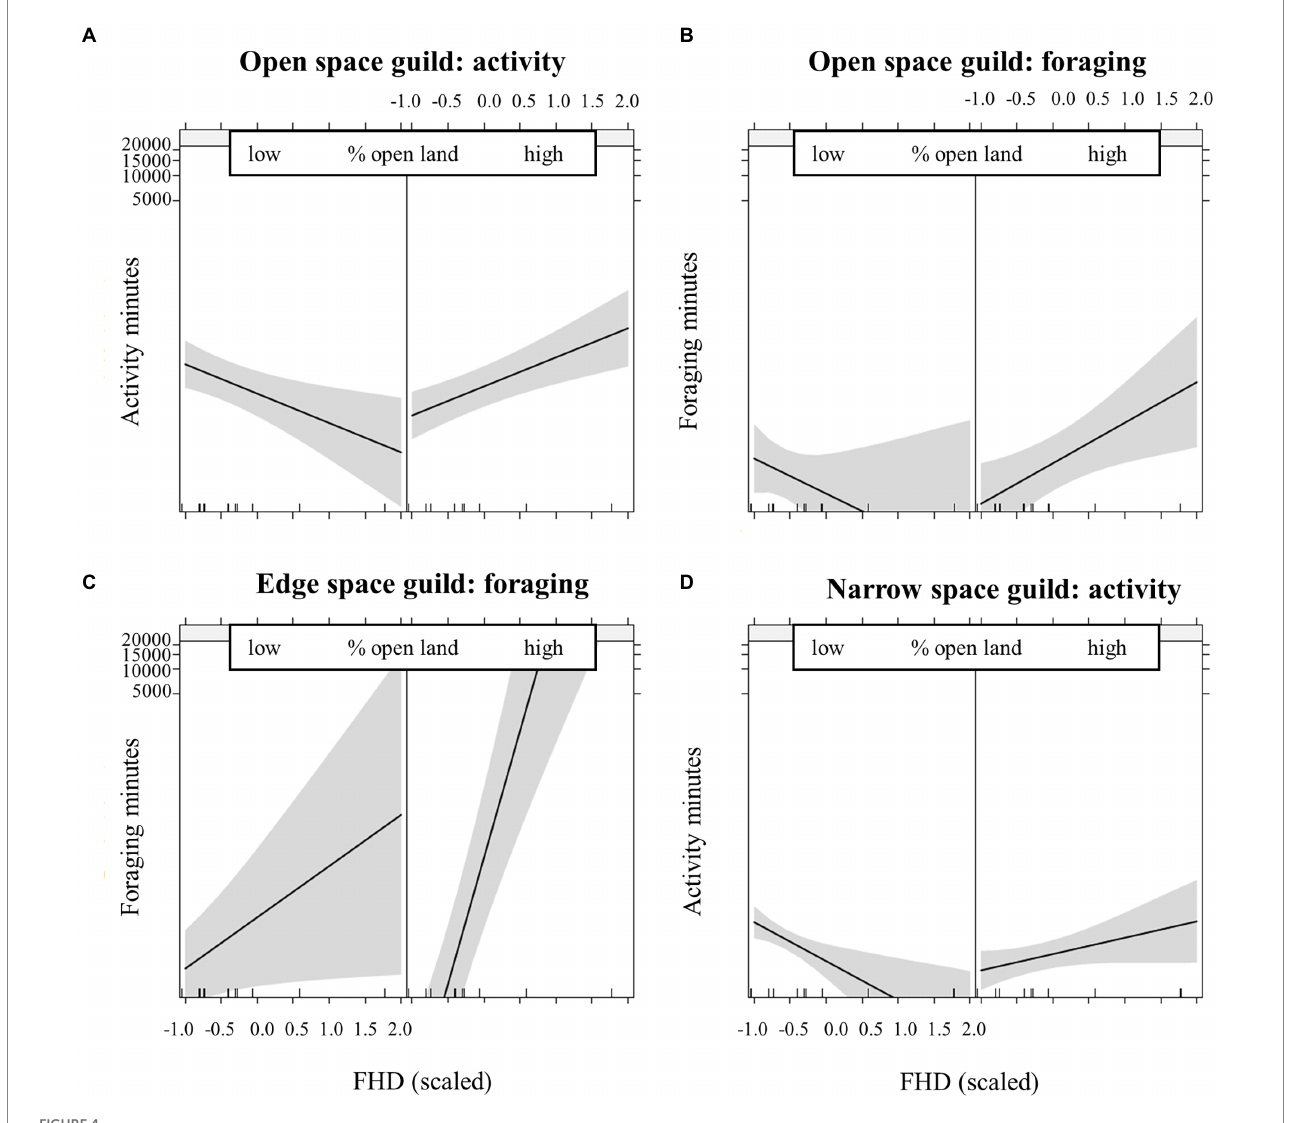
FIGURE 4 Effect plots of the interaction of the foliage height diversity (FHD, scaled) and % open land (scaled). Boxes show the predicted effects of FHD in low and high % of open land on (A) open space guild activity and (B) foraging, (C) edge space guild foraging, and (D) narrow space guild activity. Low and high values are represented by the first and third quartile of the open land data (scaled)